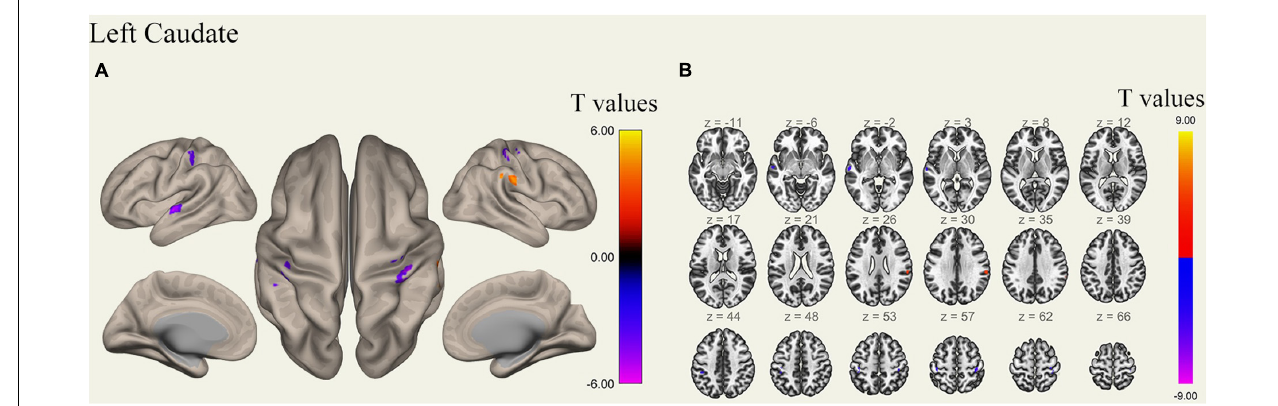
FIGURE 6 | Surface views shown at panel (A) and transverse views shown at panel (B) of brain areas that exhibited altered functional connectivity with left caudate after 36 h TSD ( n = 30). Warm colors indicate increased FC, and cold colors indicate decreased FC.